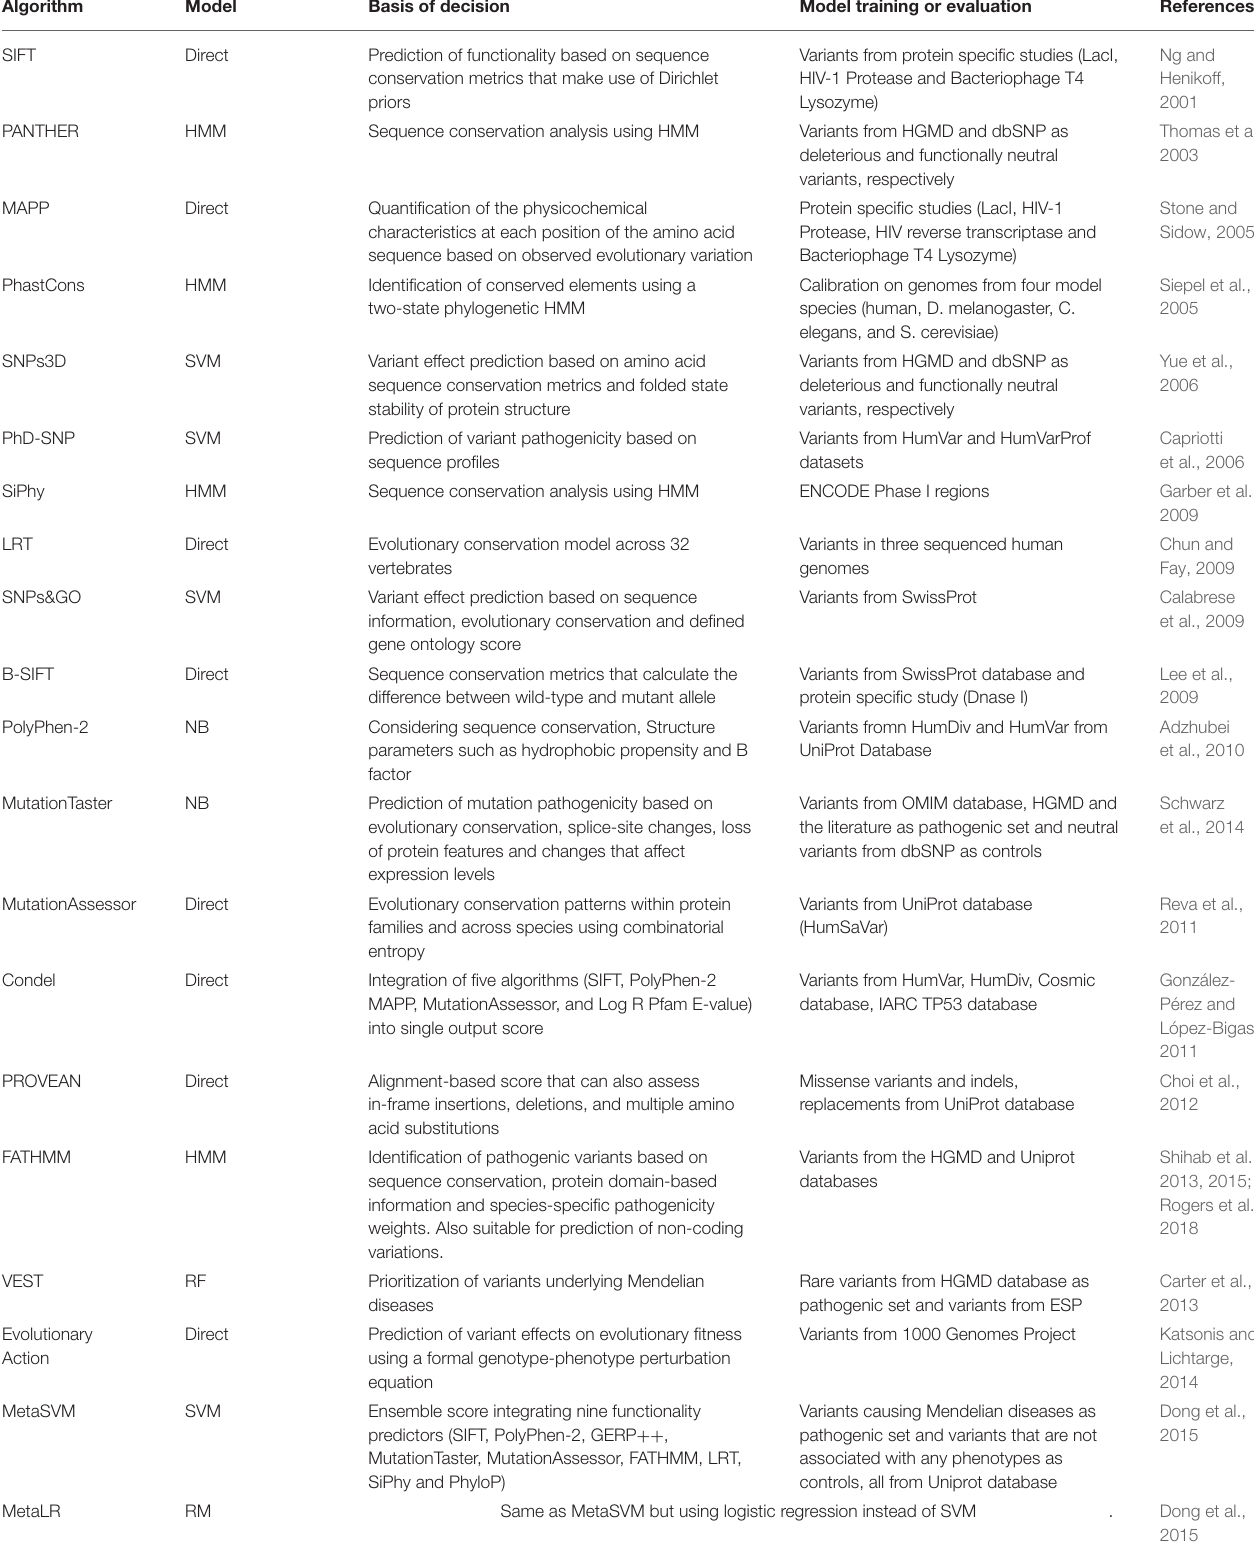
TABLE 1 | Methods to predict the functional effect of missense variants based on sequence information.